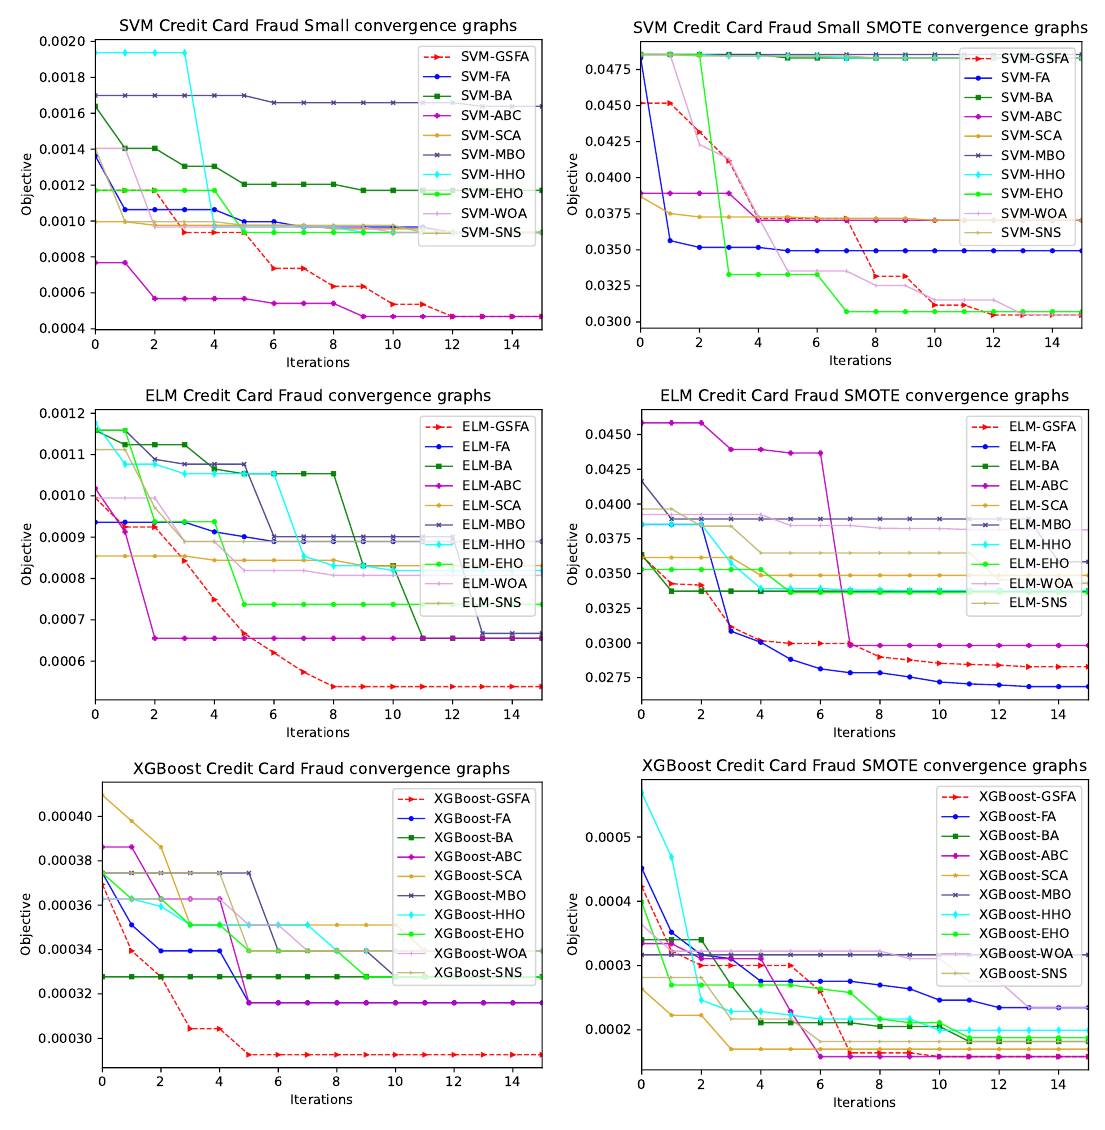
Figure 4. Convergence speed graphs of swarm algorithms for SVM, ELM, and XGBoost models for original and synthetic (SMOTE) credit card fraud